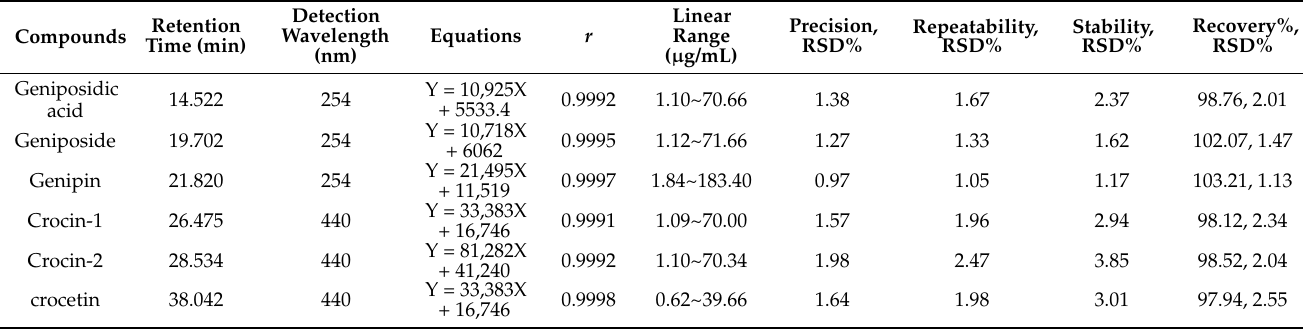
Table 1. Linear equations, correlation coefficients, precision, repeatability, stability, and recovery analysis of six compounds from Gardeniae fructus ( n =